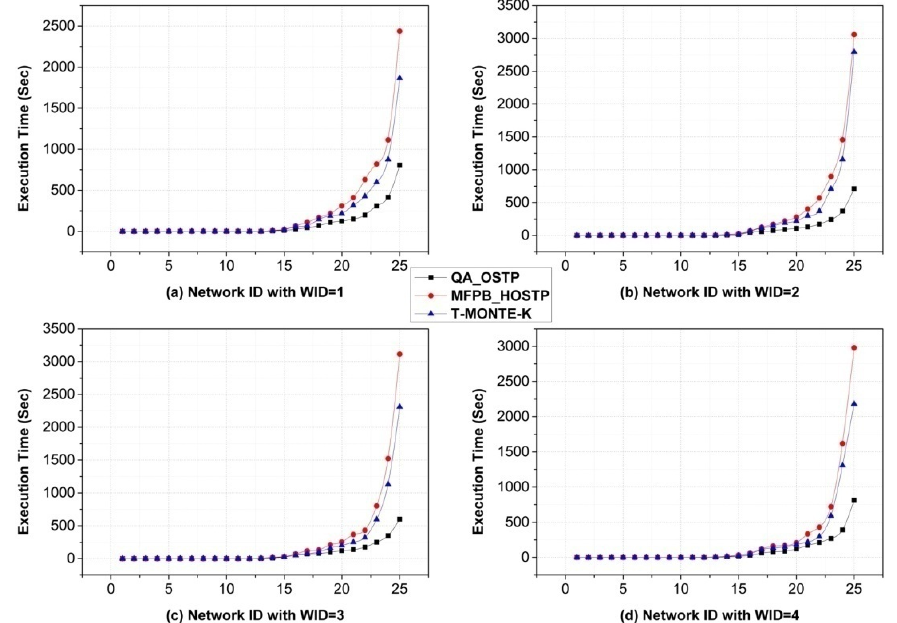
Figure 4. Comparison of execution time of algorithms.